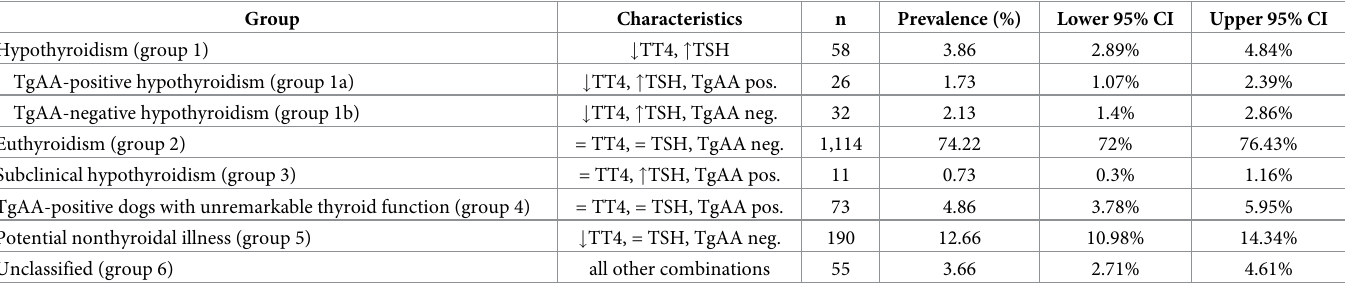
Table 1. Prevalence of hypothyroidism (group 1), subclinical hypothyroidism (group 3) and TgAA-positivity with unremarkable thyroid function (group 4) in Eur- asian dogs (N = 1,501) on initial screening.